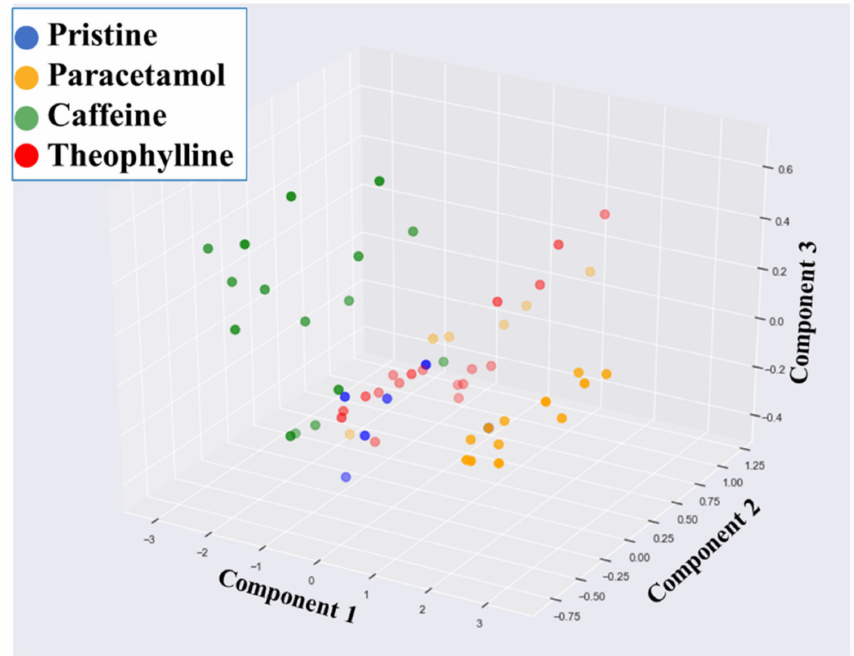
Figure 7. PCA decomposition of the raw NIR spectra to three dimensions (PCA 1—1st principal component 1; PCA 2—2nd principal